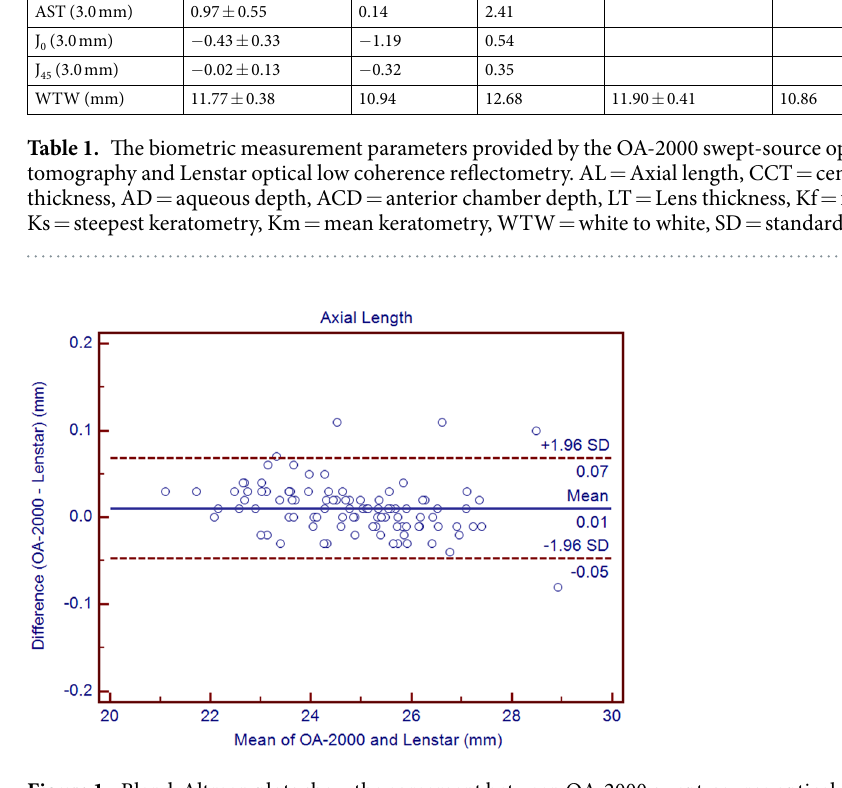
Figure 1. Bland-Altman plots show the agreement between OA-2000 swept-source optical coherence tomography and Lenstar optical low coherence reflectometry for measuring axial length. Solid lines represent the bias between both devices and dotted lines represent the 95% confidence interval for the